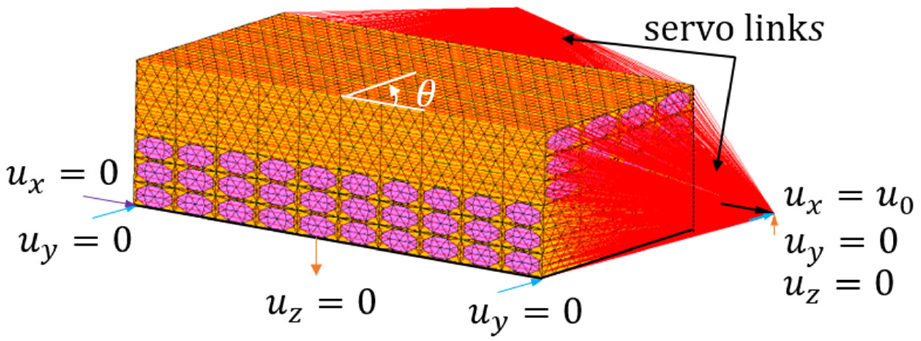
Figure 11. Boundary conditions applied to the micromechanical